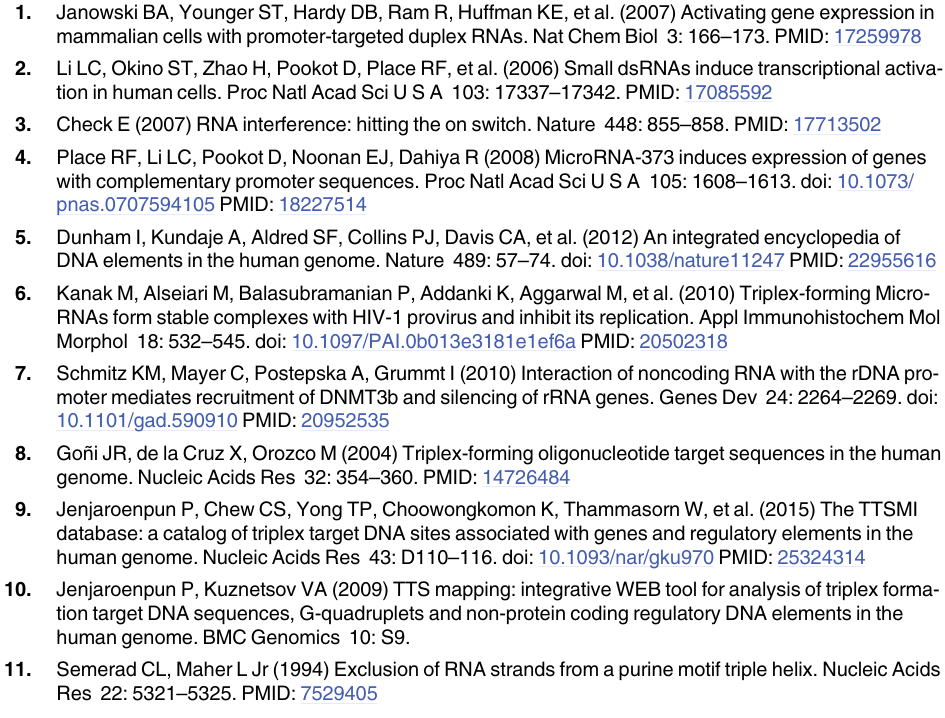
S1 Algorithm. Trident algorithm. Complete Trident Algorithm, lines 1 through